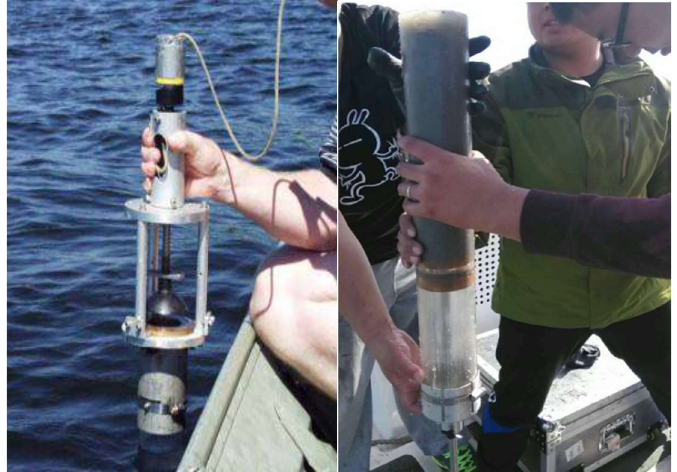
Figure 2. Sampling of sediment core in Hulun Lake.